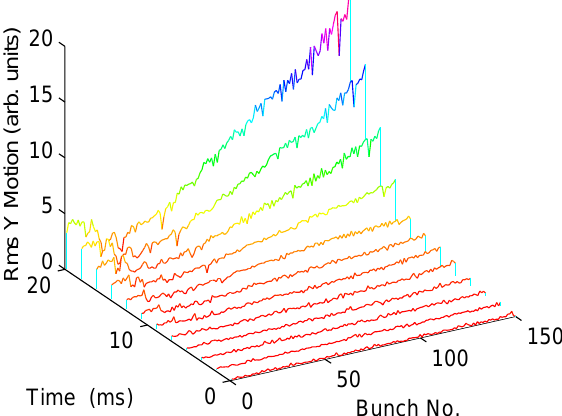
FIG. 1. (Color) Growing vertical instability transient in a 150- bunch train in the PEP-II HER at I 0 (cid:1) 52 mA. Feedback is switched off at t (cid:1) 0 . The oscillation amplitude a k of each bunch k grows exponentially over the 20 ms interval, with trailing bunches growing to larger amplitudes than leading bunches.